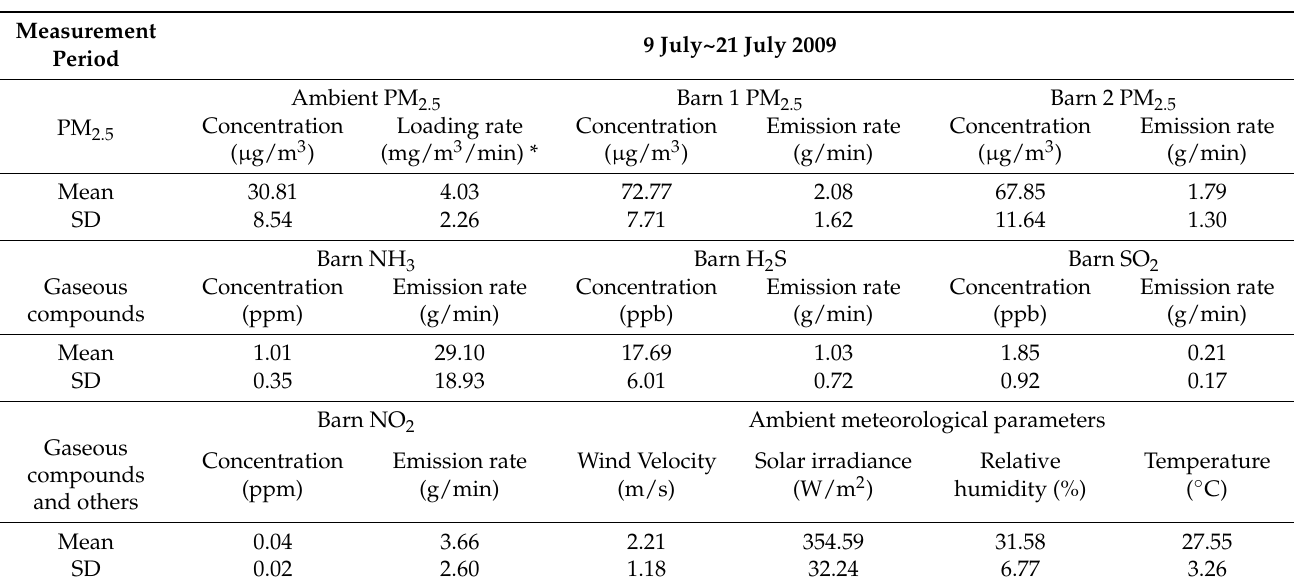
Figure 1. Description of monitoring site (Joo et al., (2015a)) [23]. Table 1. Average of PM 2.5 , gaseous compounds and meteorological parameters during the monitoring